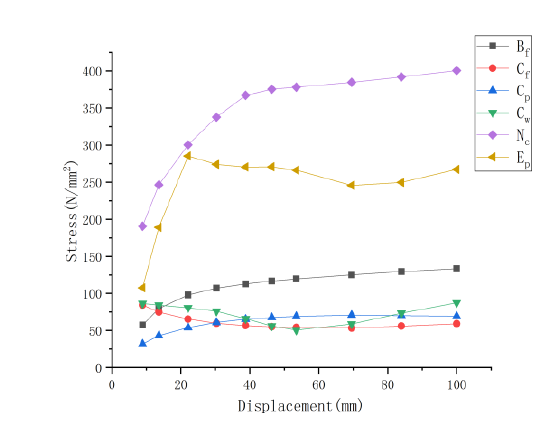
Figure 9. Stress distribution and stress history at specified points of a 4-mm end-plate.